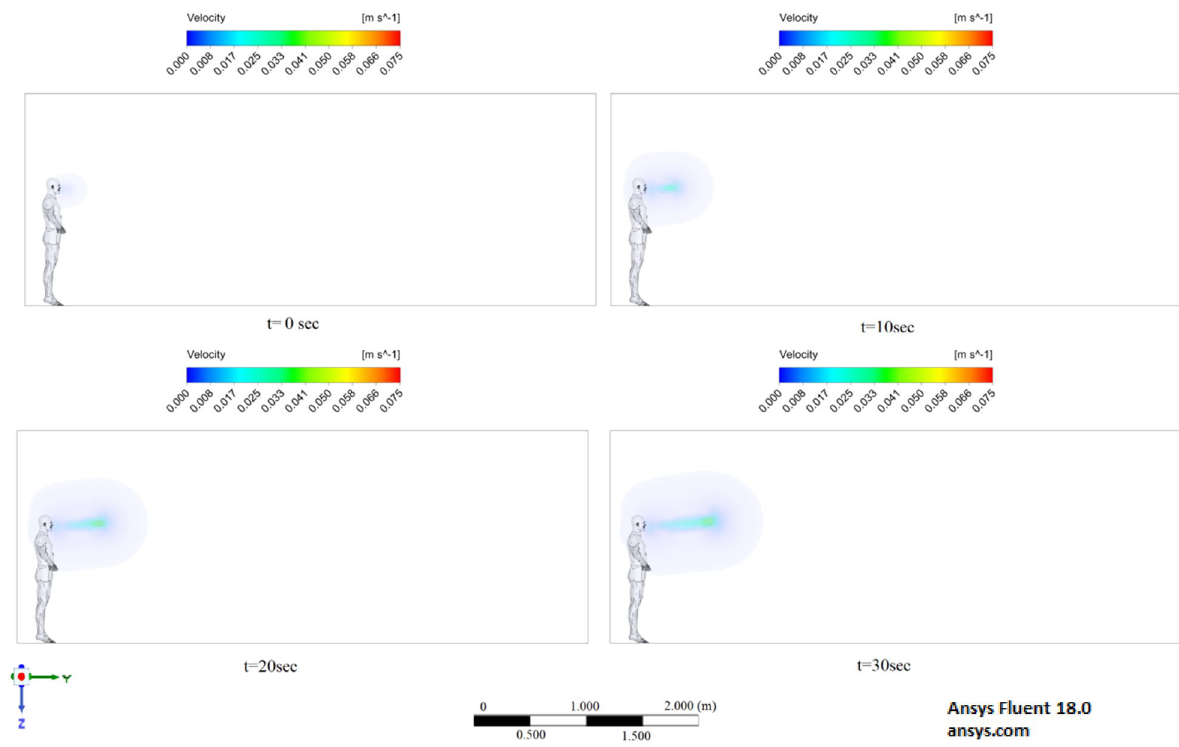
Figure 6. Cough = 1 m/s without ventilation.